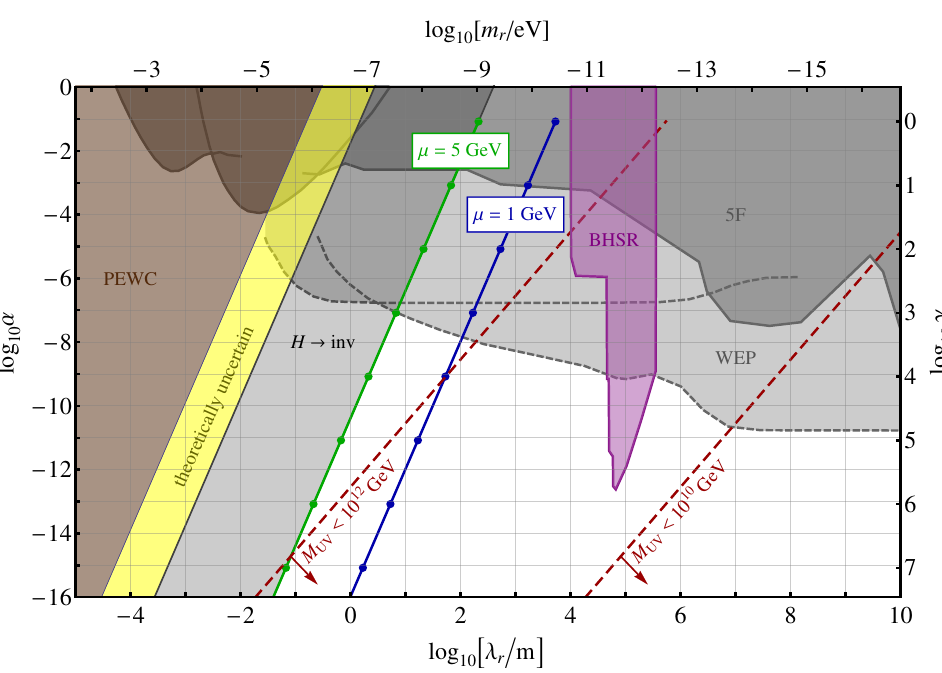
Figure 14 . Plot of the fractional change (cid:11) in Newton’s potential due to the radion Yukawa force as a function of its range set by its Compton wavelength (cid:21) r = 1 =m r . The green (red) solid line shows the radion mass-coupling relation for (cid:12)xed (cid:22) = 2 =L = 5 GeV (1 GeV) and variable (cid:13) , with dots indicating (cid:13) = 1 ; 10 ; 10 2 ; : : : from top to bottom. The darker gray region above the solid gray line is excluded by searches for a (cid:12)fth force (5F) [55{58]. The lighter gray region above the dashed gray line is excluded if the radion couplings violate the weak equivalence principle (WEP) by an (1) amount [60, 61], which can occur if SM states have di(cid:11)erent pro(cid:12)les in the extra dimension. O The brown region is excluded by precision electroweak constraints (PEWC), while the lighter gray region is excluded by null observations of the Higgs invisible width. The yellow band is theoretically uncertain. The purple shaded region is excluded by null observations of the black hole superradiance e(cid:11)ect (BHSR) [66]. The dashed red contours indicate maximum UV